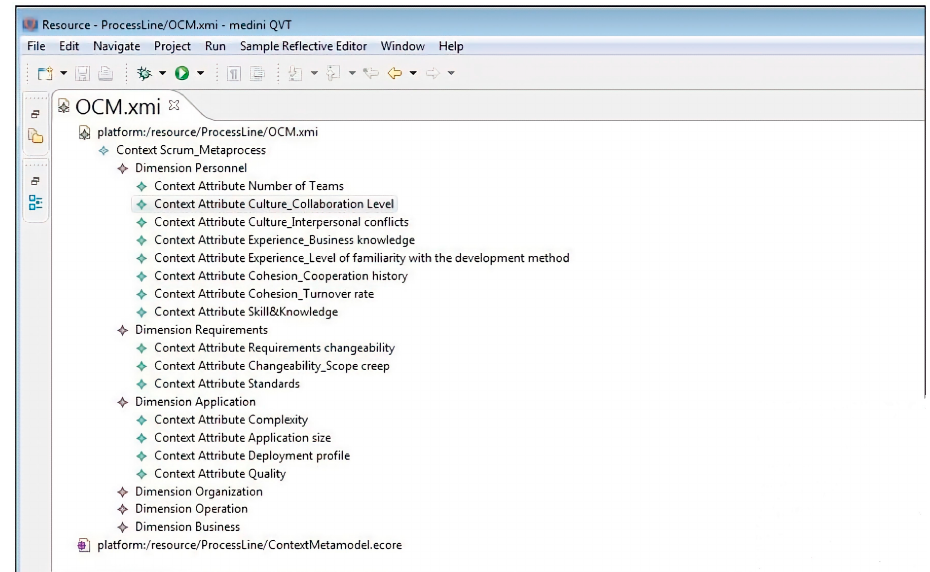
Figure A1. An instance of the context metamodel implemented in the Medini ‐ QVT tool.